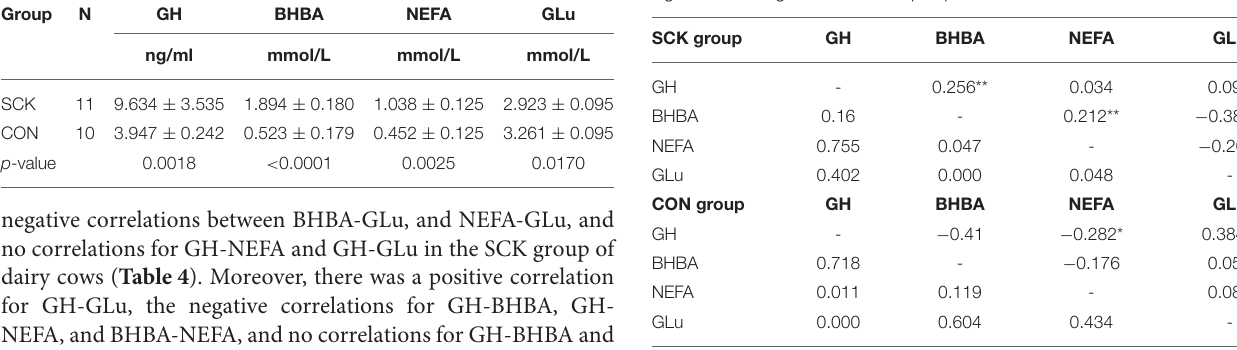
TABLE 4 | Correlation coefficient (r) analysis among plasma levels of GH, BHBA, NEFA, and GLu in SCK and CON healthy dairy cows ( n = 11) monitored weekly eight times during 0 to 7 weeks of